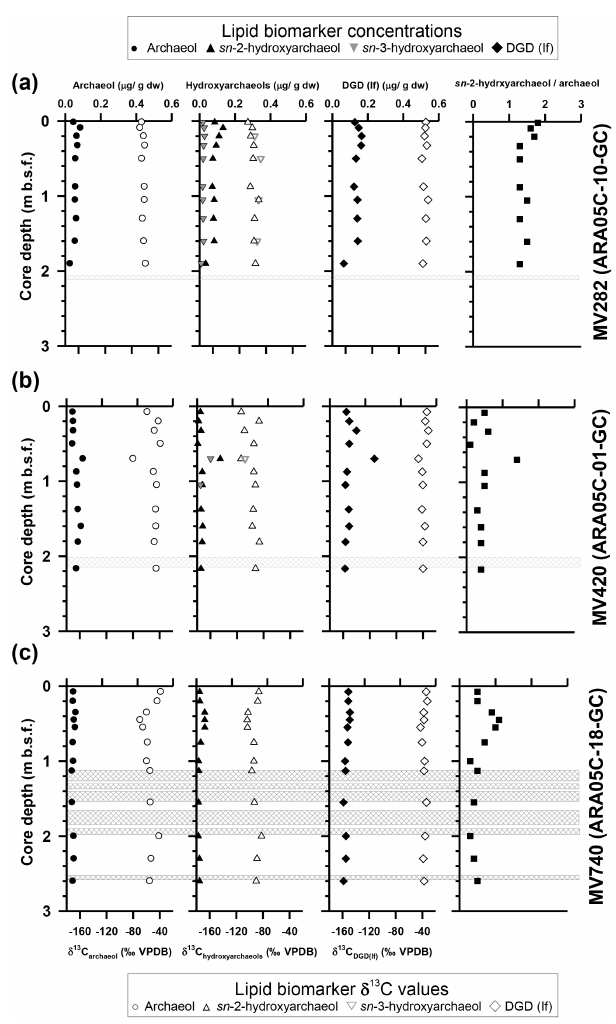
Figure 3. Vertical profiles of selected lipid biomarkers (archaeol, hydroxyarchaeol, and DGD – If) obtained from sediment cores (a) ARA05C-10-GC (MV282), (b) ARA05C-01-GC (MV420), and (c) ARA05C-18-GC (MV740). Grey hatched bars indicate gas gaps in sediment